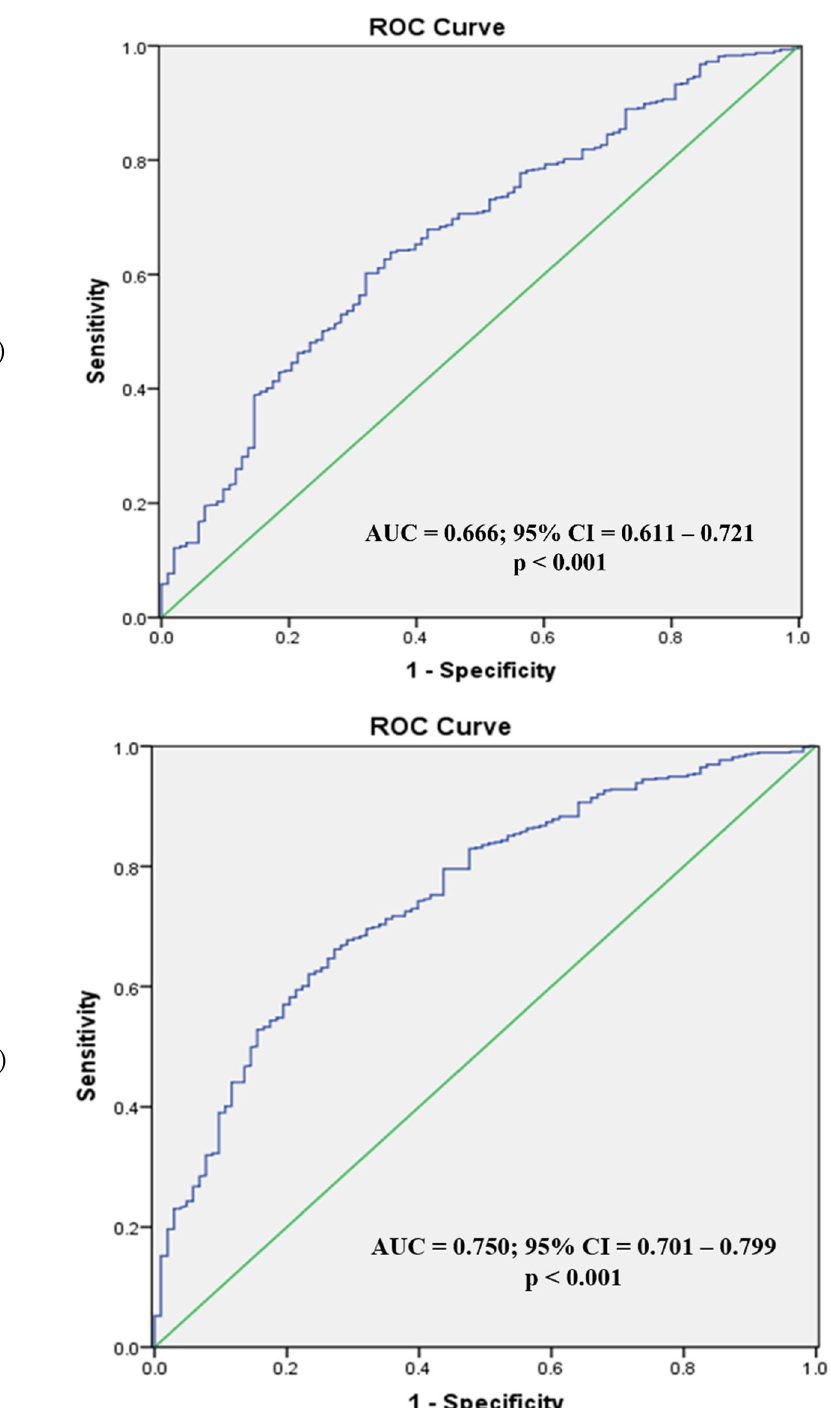
Figure 4. Receiver operating characteristic analysis of men with high BMI (body surface area ( a ), body mass index ( b )). For men with high BMI, the AUC for BSA ( a ) was 0.666 (95% CI = 0.611–0.721; p < 0.001) and for BMI ( b ) 0.750 (95% CI = 0.701–0.799; p < 0.001). ROC, receiver operating characteristic; AUC, area under the curve; CI, confidence interval.